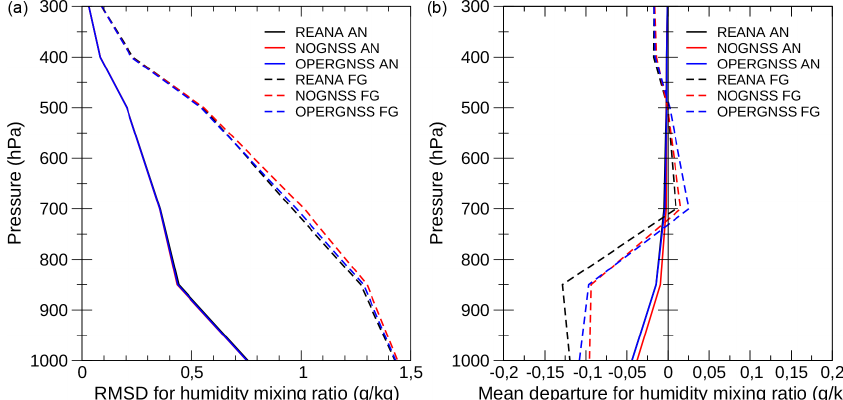
Figure 3. Root mean square differences (RMSDs) (a) and mean (b) for analysis (AN, solid lines) and first-guess (FG, dashed lines) departures against assimilated radio-sounding observations for the mixing ratio (gkg − 1 ); REANA in black, NOGNSS in red and OPERGNSS in blue.